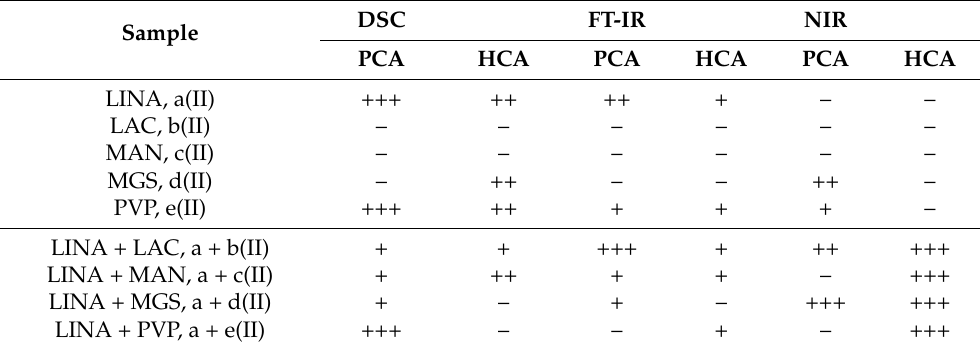
Table 2. Effects of high temperature/high humidity (60 ◦ C/70% RH) on linagliptin (LINA), excipients (LAC, MAN, MGS and PVP) and their binary